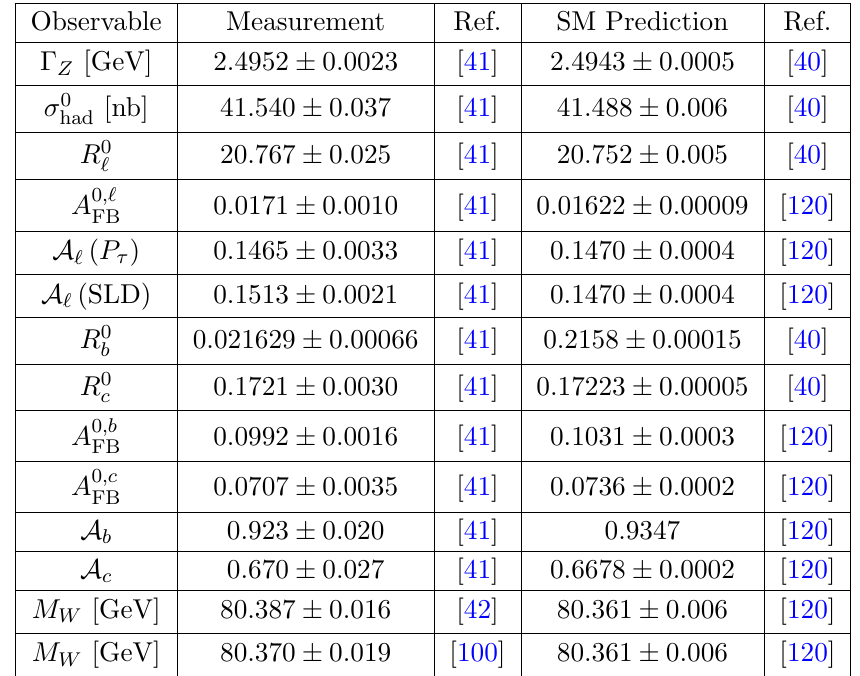
Table 1. Summary of the precision electroweak data used in our global